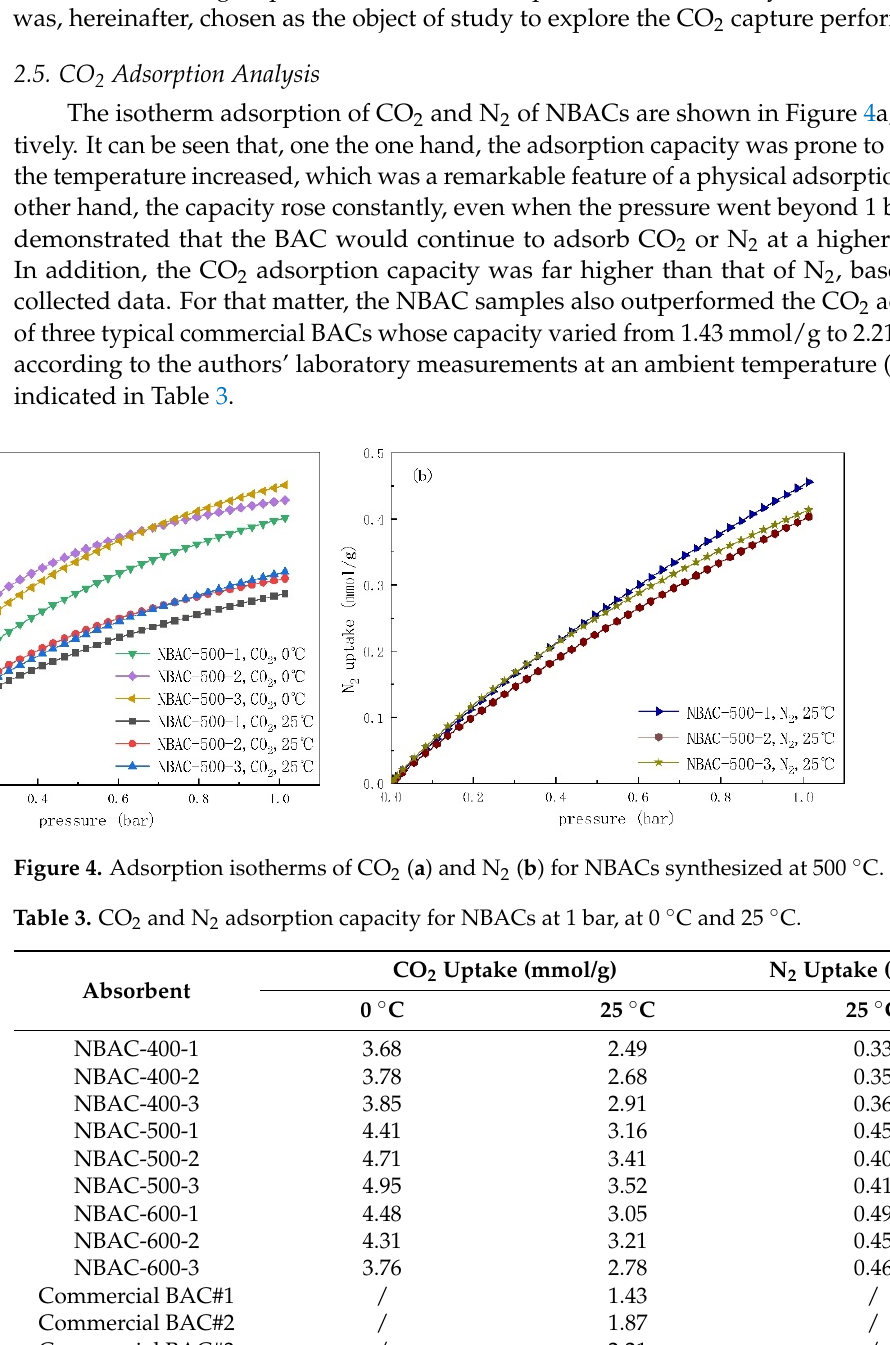
Figure 3. XPS spectra of NBAC-500-3 ( a ) and fitting curves of NBAC-400-3 ( b ), NBAC-500-3 ( c ) and NBAC-600-3 ( d ) synthesized from dry chemical activation.